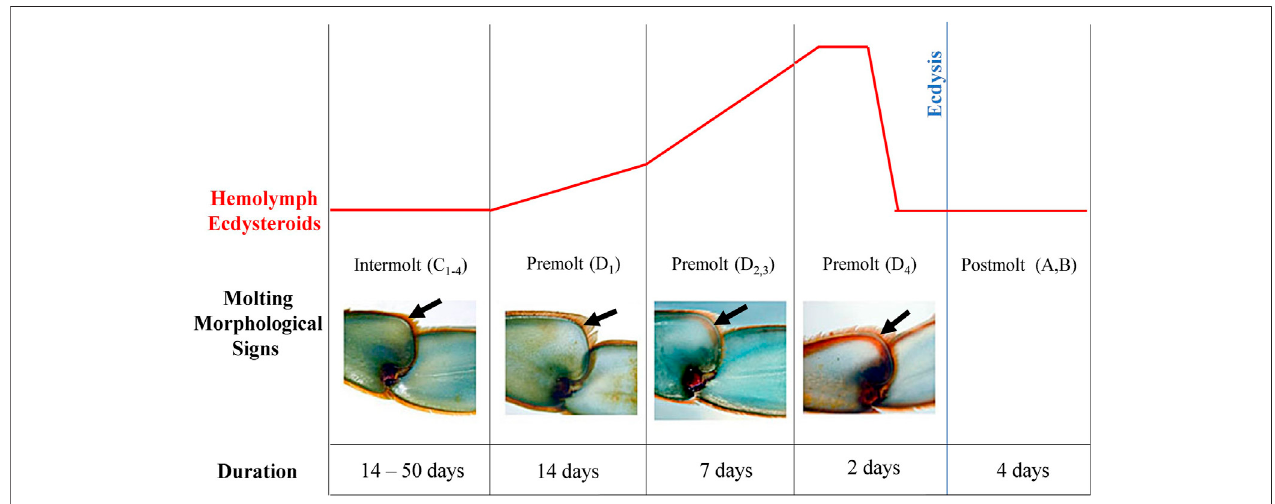
FIGURE1| Illustrationofmoltcycleofthebluecrab, Callinectessapidus .Thediagramshowsthehemolymphecdysteroidtiterpattern(upperpanel),morphological signalsoftheleg(blackarrows),anddurationofeachstageduringthemoltcycle(bottompanel).Modi fi